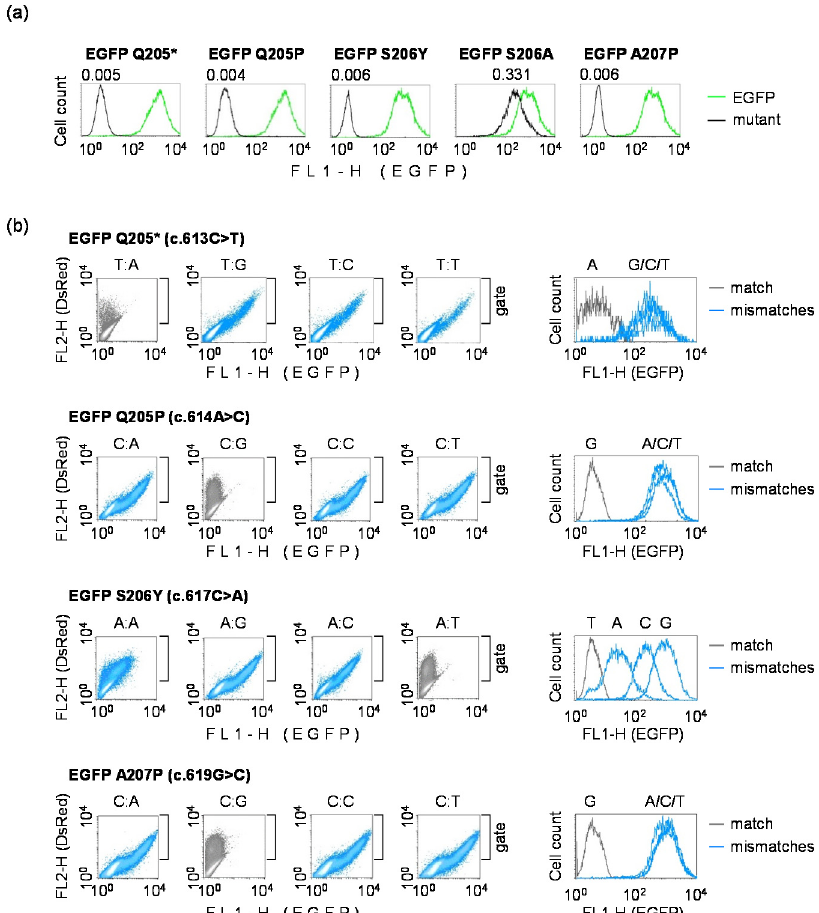
Figure 3. Validation of the candidate EGFP loss-of-function variants containing di ff erent nucleotide pairs at the mutation site: ( a ) Quantitative flow cytometry analyses of cloned EGFP mutants selected based on the low fluorescence signal in the preliminary screen. HeLa cells were transfected with vectors encoding the specified EGFP mutants or the original EGFP, in the presence of DsRed-Monomer as a transfection marker to generate the overlaid fluorescence distribution plots, as explained in Figure 1. Values above the peaks report fluorescence intensities relative to the original EGFP (calculated from the median FL1-H); ( b ) Reversal to the fluorescent phenotype by targeted single nucleotide substitutions in the TS. Expression vectors for the indicated EGFP mutants were used to generate all possible mismatches (blue color) or a correct base pair (grey color) by ligation of the respective synthetic oligonucleotides. EGFP fluorescence was analyzed in transfected DLD1 cells. For the efficient detection of mutagenesis at a target nucleotide in the TM or TLS assays, it would be essential to verify that subsequent base substitutions at the affected position efficiently restore the EGFP fluorescence. This was expected based on the results of the preliminary screening (Figure 2); however, the former approach was potentially prone to false positives, because construction of mismatched templates for the screen then departed from the fluorescent EGFP version. To test all 16 sequence variants more rigorously, we used a single ‐ strand substitution approach applied previously, but inverted the detection principle by starting from inherently non ‐ fluorescent EGFP. In each of the identified EGFP loss ‐ of ‐ fluorescence mutants, we replaced the TS fragment comprising nucleotides 608–625 for different synthetic strands, containing each of the four nucleotides at the positions of the primary base substitutions in the respective mutants (as described in the Methods Section 2.4.). An analysis of the EGFP fluorescence in DLD1 cells showed that all nucleotide substitutions in the TS at the primary mutation sites led to the at least partial restoration of the EGFP fluorescence (Figure 3b), whereas strand replacements not leading to nucleotide substitutions (NTS:TS 613T:A in Q205*; 614C:G in Q205P; 617A:T in S206Y; and 619C:G in A207P) all retained the